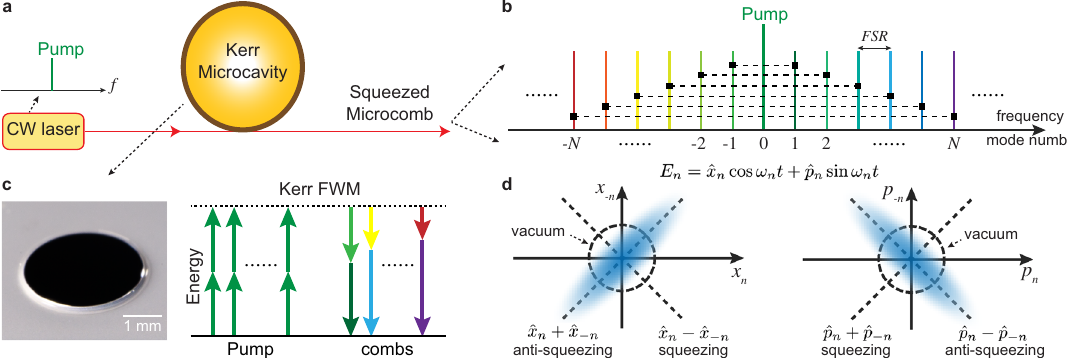
Fig. 1 Generation of deterministic, two-mode squeezed quantum microcombs on a chip. a A continuous-wave (cw) pump laser is coupled to a microresonator, which has thousands of longitude resonance modes with their frequencies separated by the resonator free-spectral-range (FSR), as shown in ( b ). c The χ (3) Kerr nonlinearity in the microresonator creates broadband parametric gain as the pump photon pairs (green) can be converted into signal and idler photons at lower and higher frequency modes. This nonclassical correlation creates two-mode vacuum squeezing and thus unconditional EPR entanglement of the optical quadrature fi elds between frequency modes n and − n , which are connected by dashed black lines in the optical spectrum in ( b ). Also shown is the image of a silica microresonator on a silicon chip used in this work. d Conceptual illustration of the two-mode squeezing wavefunctions in position (left) and momentum (right) basis, where ( ^ x n − ^ x (cid:2) n ) and ( ^ p n + ^ p (cid:2) n ) have uncertainty level below the vacuum fl uctuation (dashed circle). The electrical fi eld of the n -th optical mode is E n ¼ ^ x n cos ω n t þ ^ p n sin ω n t , where ^ x n and ^ p n are the in-phase and out-of-phase quadrature amplitudes of the mode at frequency ω n representative quadrature noise variance (blue) relative to the shot noise (red) for qumodes ( − 4, 4). A 30-point moving average is used to smooth out the fl uctuations in the noise variance measurement. The raw squeezing of 1.6 ± 0.2 dB and anti-squeezing of 5.5 ± 0.1 dB are directly observed, and they are obtained by averaging the displayed extrema. The uncertainty is concluded with a 95% con fi dence interval under t-distribution.